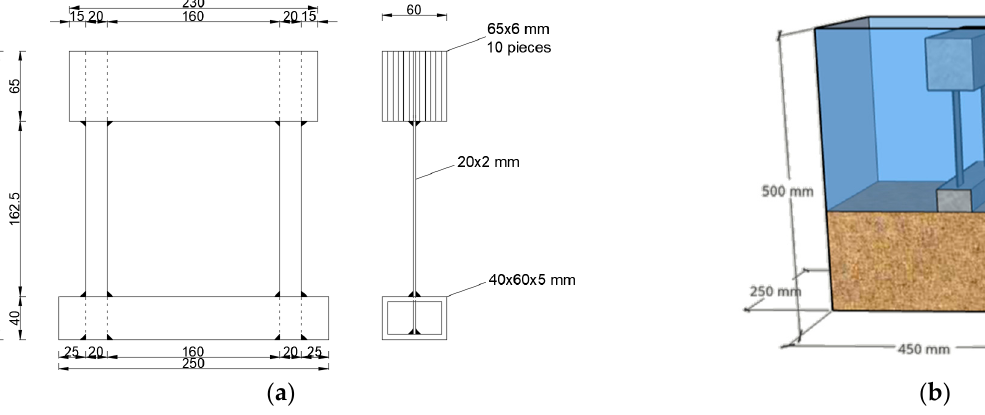
Figure 1. ( a ) Physical experimental model, ( b ) sand container.